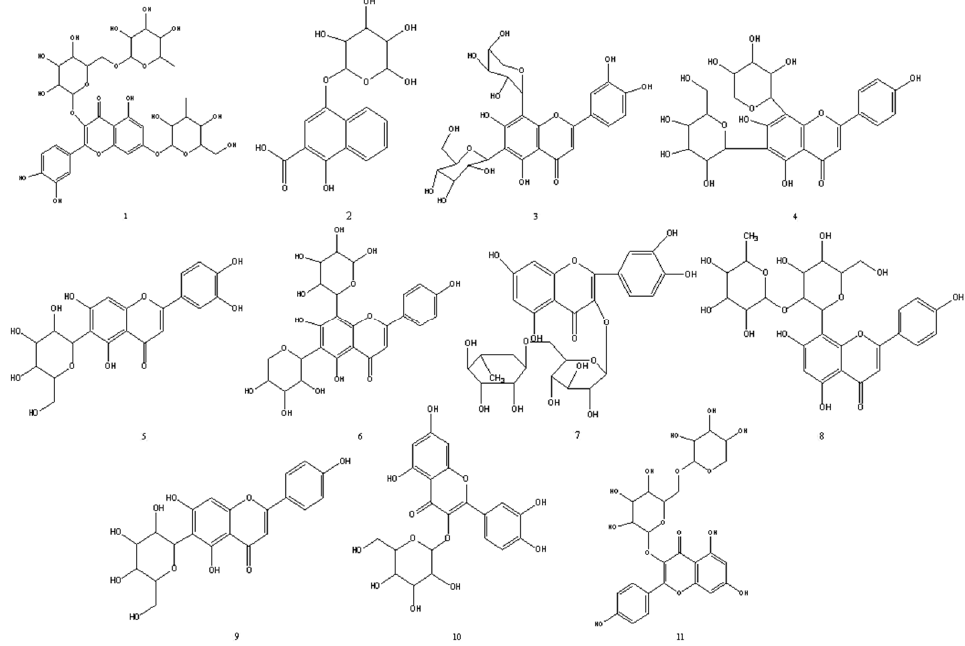
Figure 4. Chemical structures of 11 compounds in fig leaves. 1. 3-O-(rhamnopyranosyl-glucopyranosyl)-7-O-(glucopyranosyl)-quercetin; 2. 2-carboxyl-1, 4-naphthohydroquinone-4-O-glucopyranoside; 3. luteolin 6-C-glucopyranoside, 8-C-arabinopyranoside; 4. schaftoside; 5. isoorientin; 6. isoschaftoside; 7. rutin; 8. 2 ″ -O-rhamnosylvitexin; 9. isovitexin; 10. isoquercetin; 11. kaempferol-3-O-rutinoside.